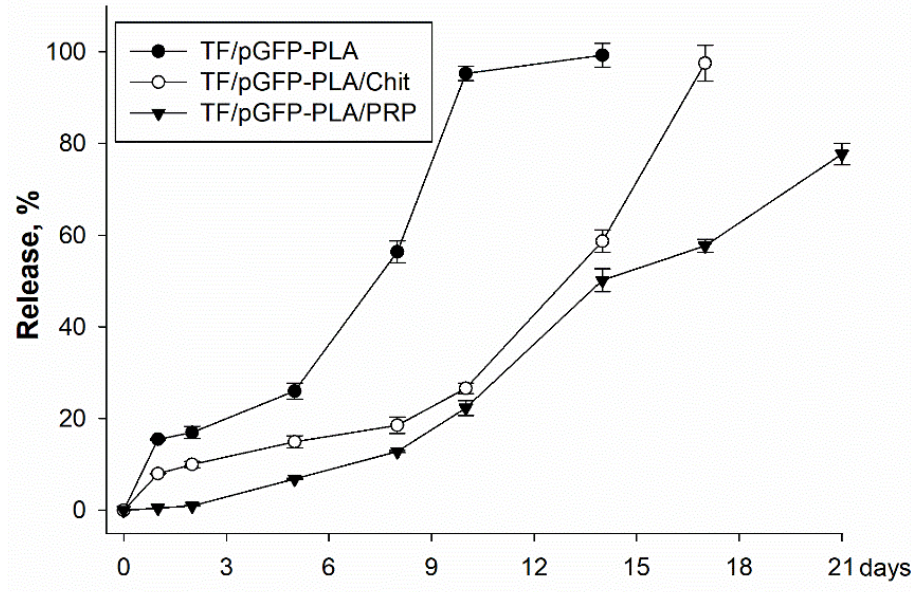
Figure 4. Release of TF/pGFP polyplexes from matrices, spectrophotometry. obtained matrices impregnated with the TF/pGFP polyplexes (Figure 5a). GFP